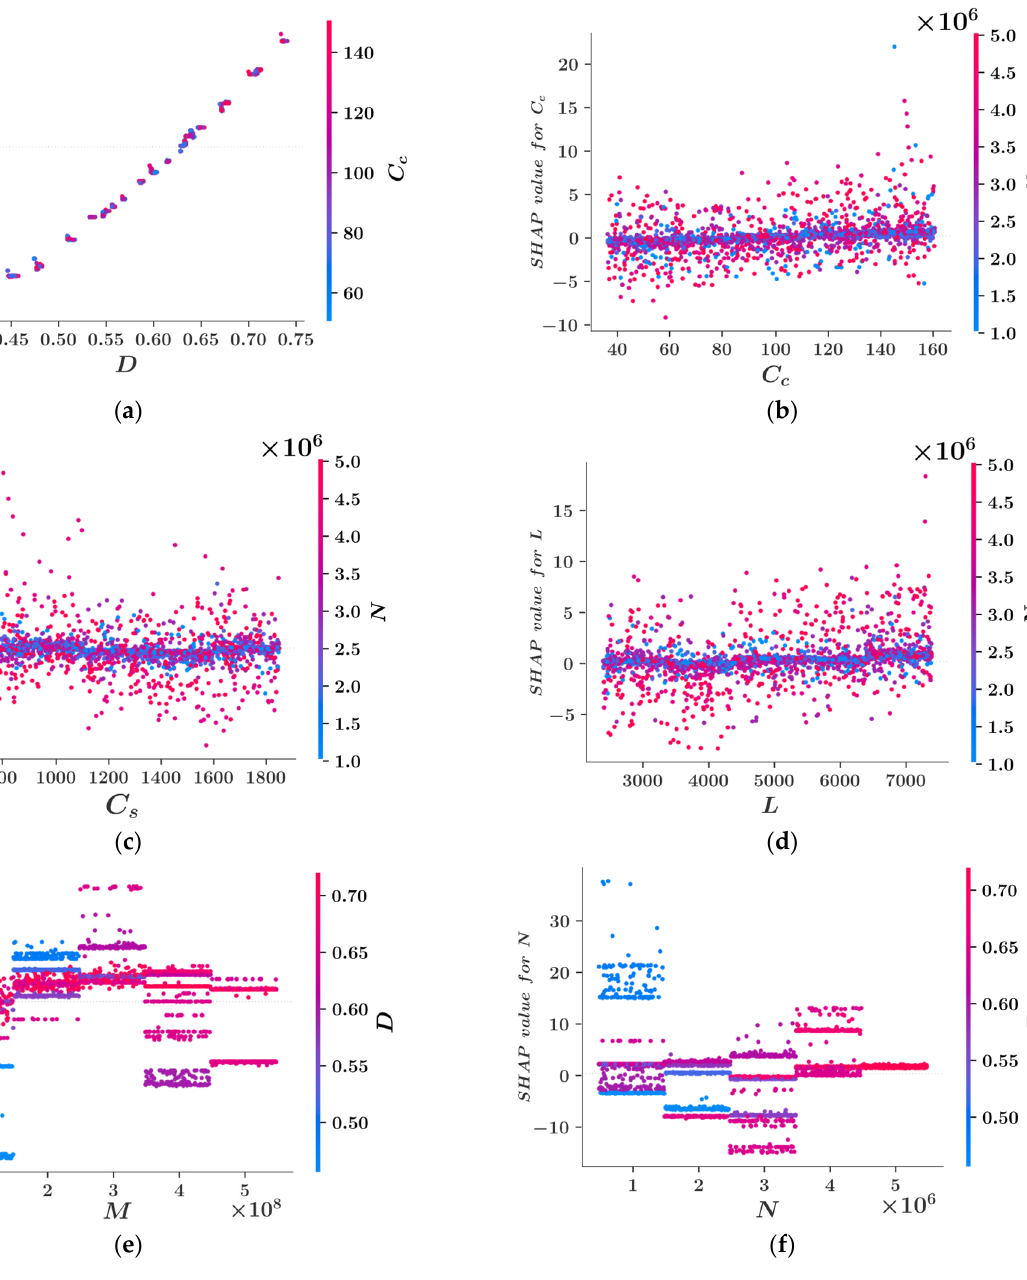
Figure 8. Feature dependence plots for the variables ( a ) D, ( b ) C (cid:2913) , ( c ) C (cid:2929) , ( d ) L, ( e ) M, ( f ) N.